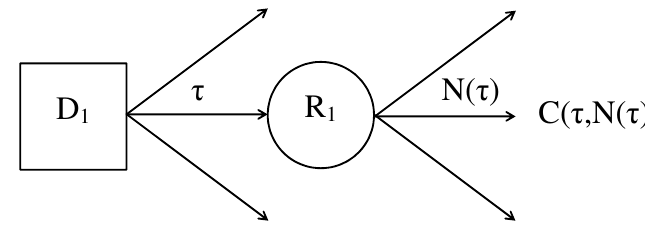
Figure 5. Decision tree for a single-period replacement